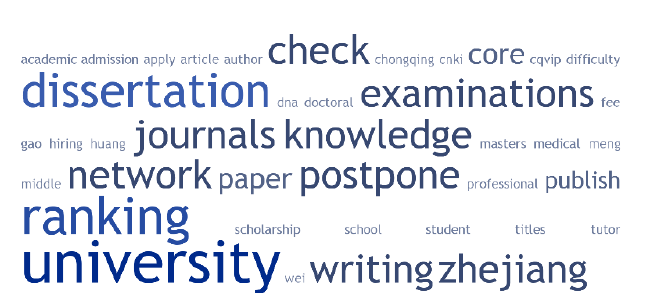
Figure 10. Keyword cloud (translated from Chinese).